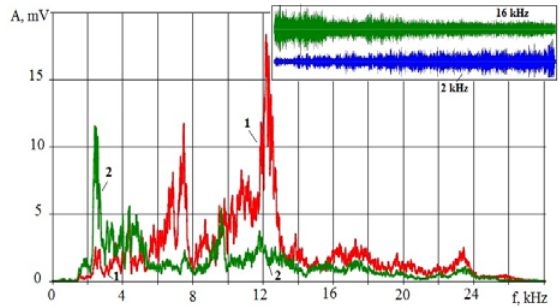
Fig. 5 . The layout of sensors on EDM machine: а – EDM generator, W – workpiece, TE – tool-electrode, A – accelerometer, CS – current sensor, ADC – analogue-to- digital converter, PC – personal computer; b – scheme of the current sensor